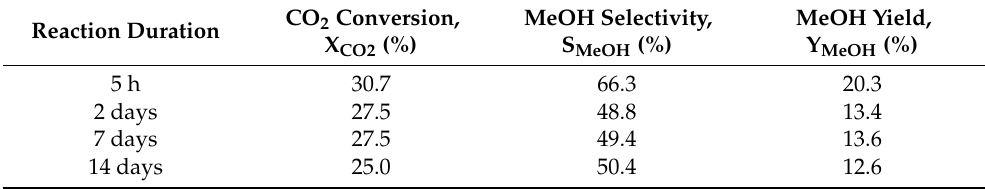
Table 1. Catalytic performance of CZMNZA catalyst in extended reaction